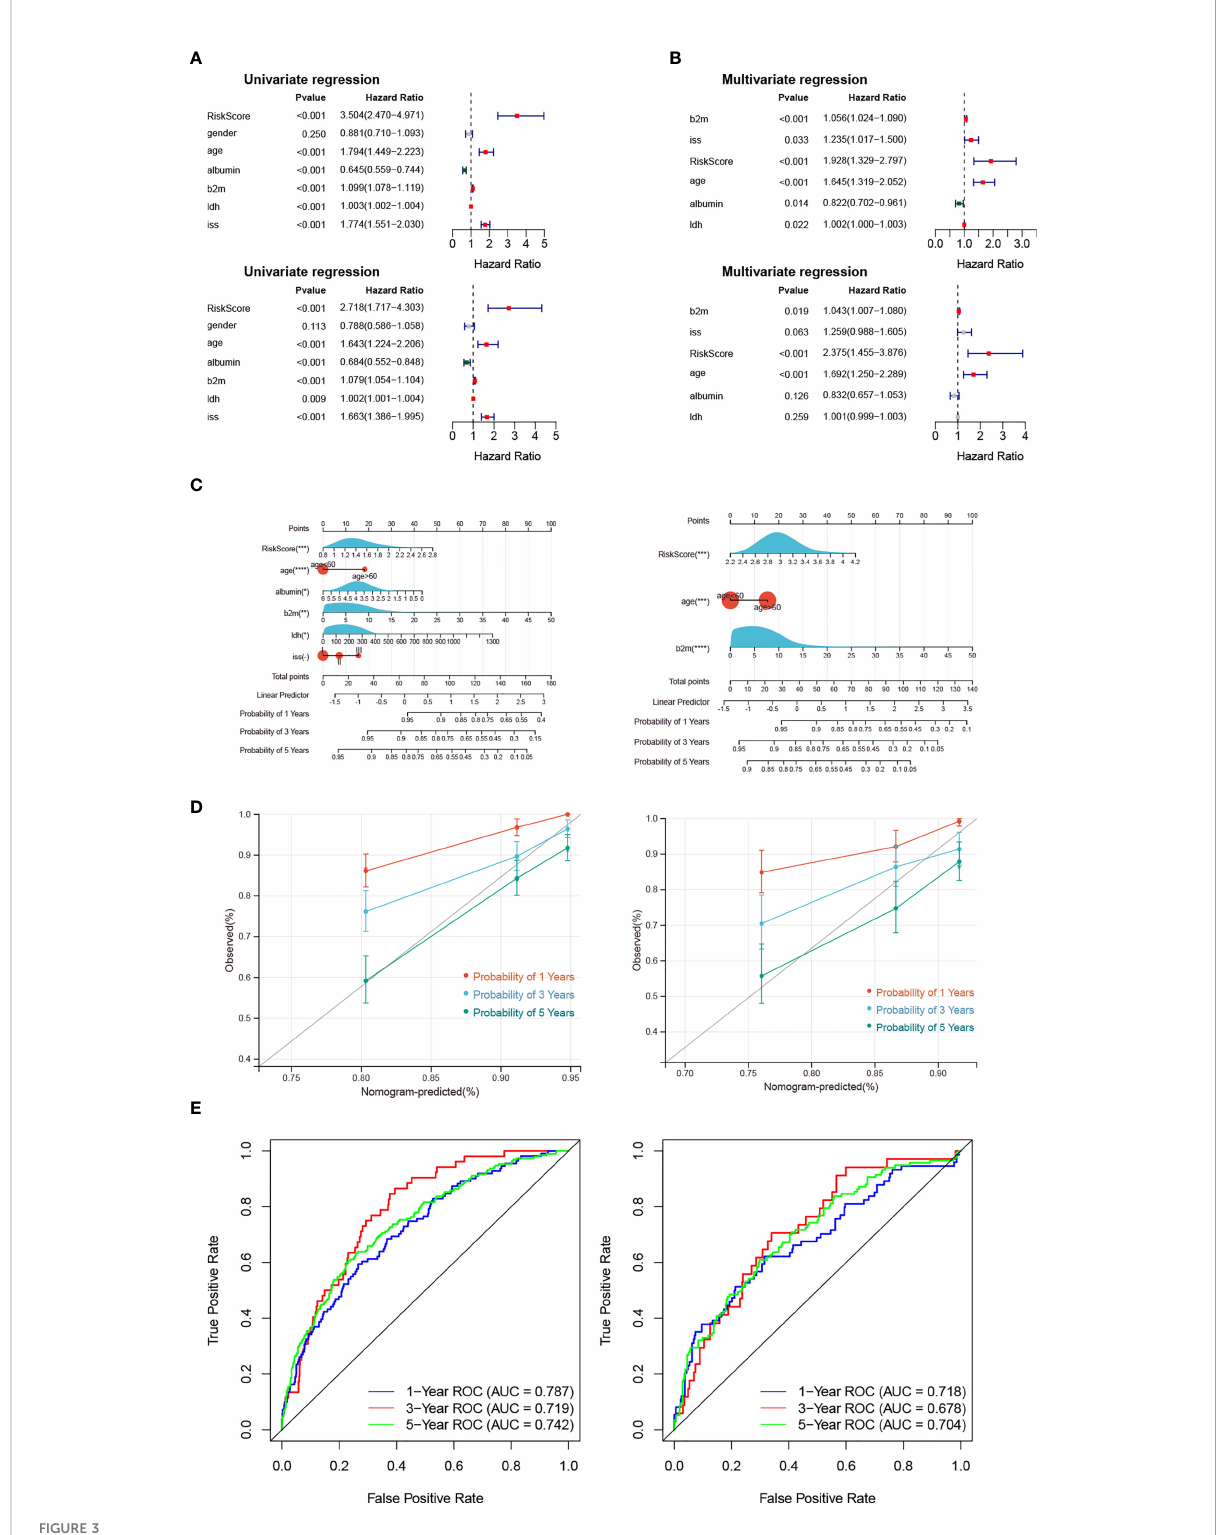
FIGURE 3 The Risk Score is an independent prognostic indicator. (A, B) The forest plot of hazard ratios for clinicopathological characteristics by Cox analysis. The upper panel shows the GSE136324 training cohort, and the lower panel shows the GSE136337 validation cohort. (C – E) The nomogram was used to show the survival probability at 1-, 3- and 5-years. The correction curves and the ROC curves were utilized to verify the ef fi ciency of the nomogram. The left panel shows the GSE136324 training cohort, and the right panel shows the GSE136337 validation